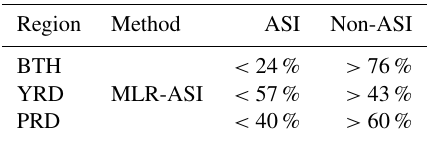
Table 4. Contributions of ASI and residuals (non-ASI) to the ob- served PM 2 . 5 trends in 2013–2018.